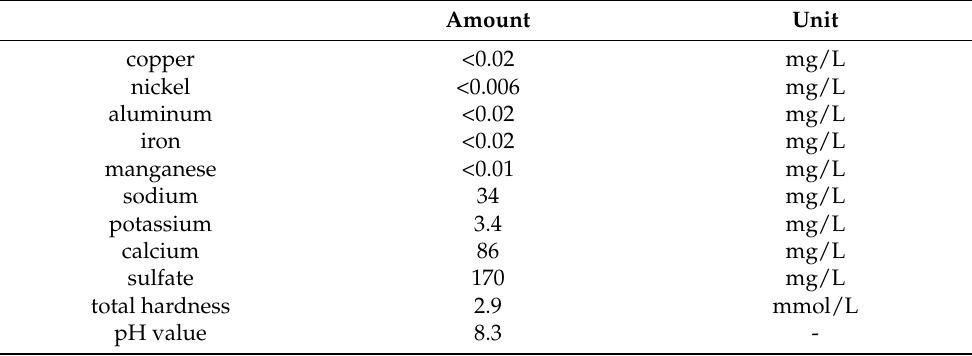
Table 1. Extract from the official water analysis, provided by the local water supplier